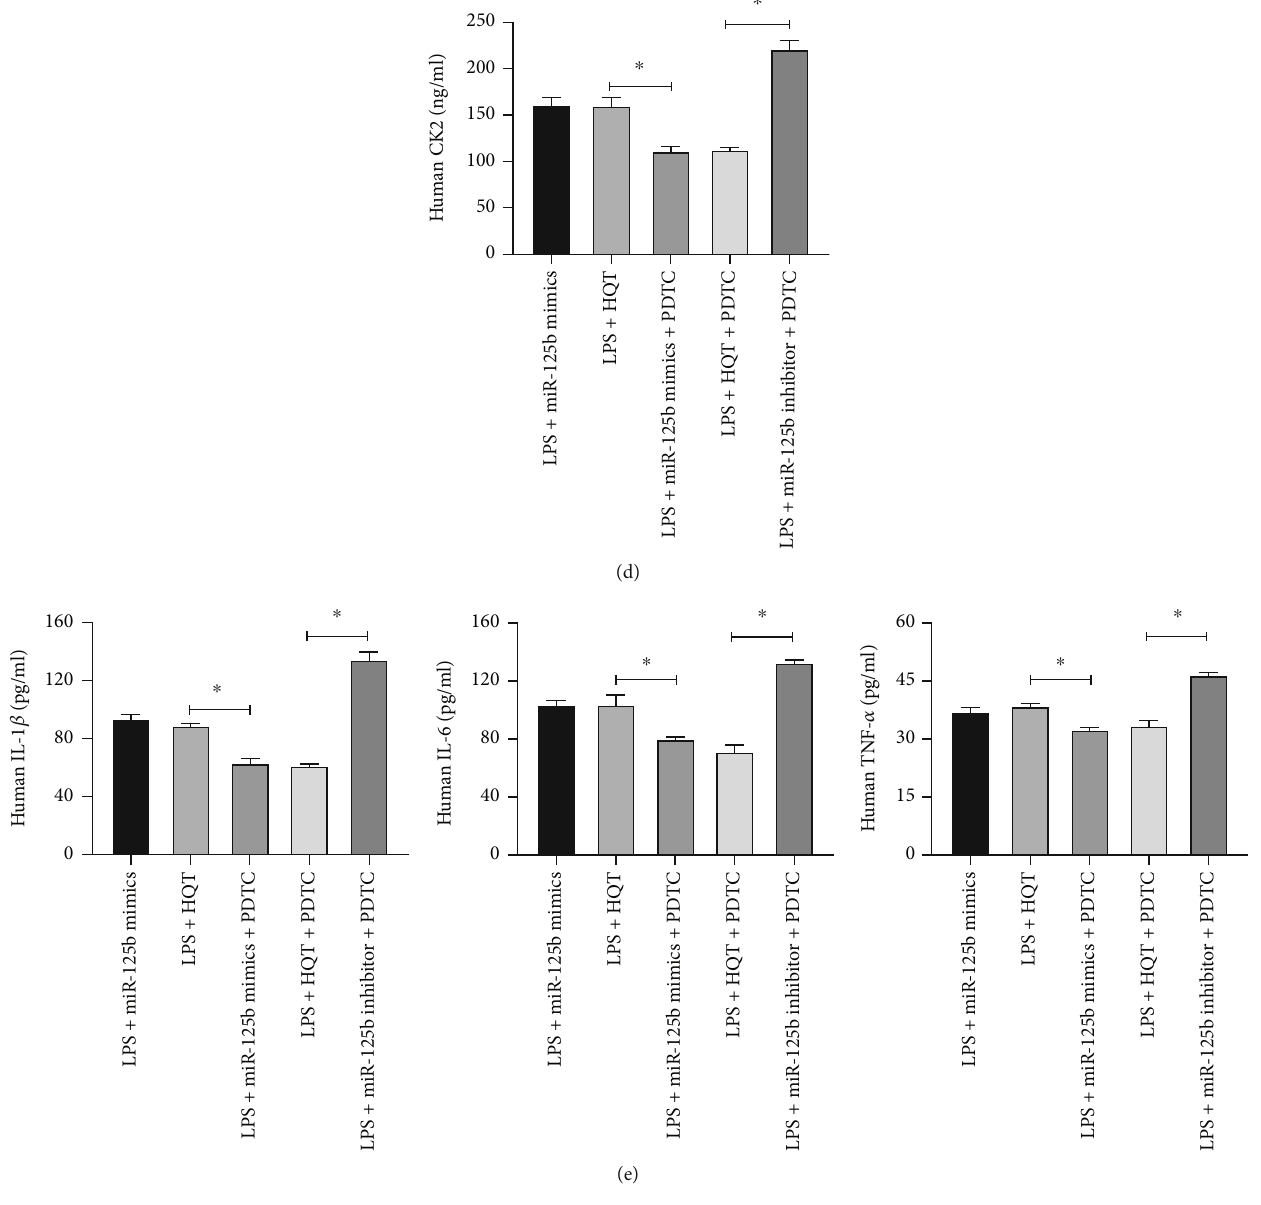
Figure 5: HQT ameliorates LPS-induced in fl ammation through upregulating miR-125b to suppress NF- κ B-induced in fl ammation by targeting CK2. (a) MH7A cells were treated with di ff erent concentrations of HQT such as 0, 0.1, 1, 10, and 100mg/mL for 24h; cell viability was evaluated via the CCK-8 assay. (b – e) MH7A cells were transfected with miR-125b mimics or miR-125b inhibitor and then treated with LPS and PDTC. (b) The mRNA expression of miR-125b, pre-miR-125b, and pri-miR-125b was evaluated via qRT-PCR. (c) The protein level of p-p65 and p-IkB- α was evaluated via western blot. (d) Human CK2 concentration in the cultured supernatant was measured by using an ELISA assay. (e) The cytokine protein levels including TNF- α , IL-1 β , and IL-6 in the cellular supernatant were measured by using an ELISA assay. N = 3 , ∗ p < 0 : 05 , ∗∗ p < 0 : 01 , and ∗∗∗ p < 0 : 001